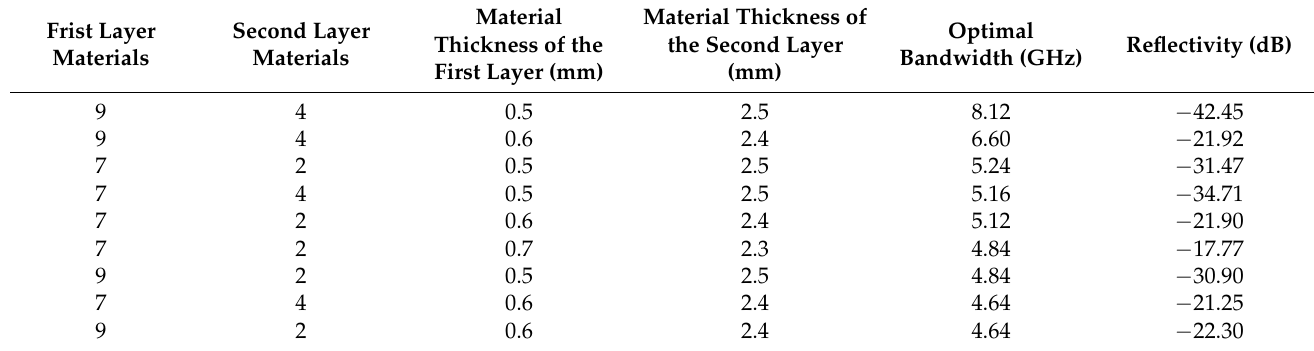
Table 2. The optimization results using objective function F1 (two-layers) of GA algorithm. Frist Layer